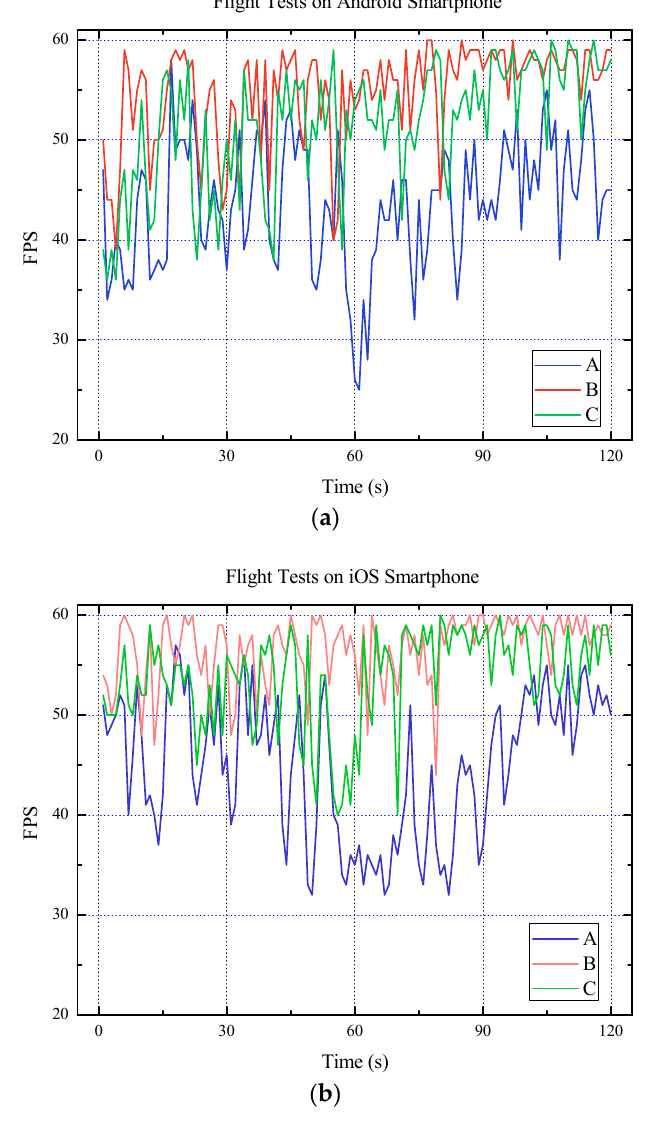
Figure 4. Tests of the influence of reducing the maximum tile level that can be loaded on the rendering frame rate: ( a ) flight tests on the Android smartphone; ( b ) flight tests on the iOS smartphone.